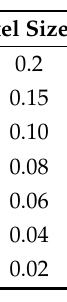
Figure 12. Time Consumption of different modules, including rendering, semantic segmentation, reconstruction, and fusion. The total time is about 65 ms in average. Table 4. 20k points per frame.